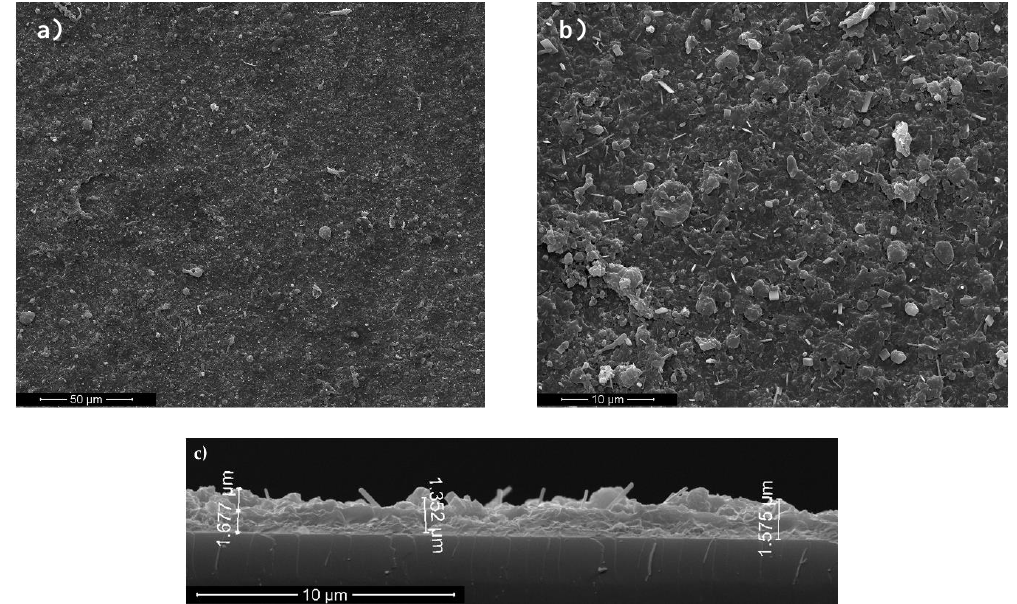
Figure 1. Typical SEM micrographs for BGN / PMMA coated substrates: ( a ) overview, ( b ) detail, ( c ) cross section.